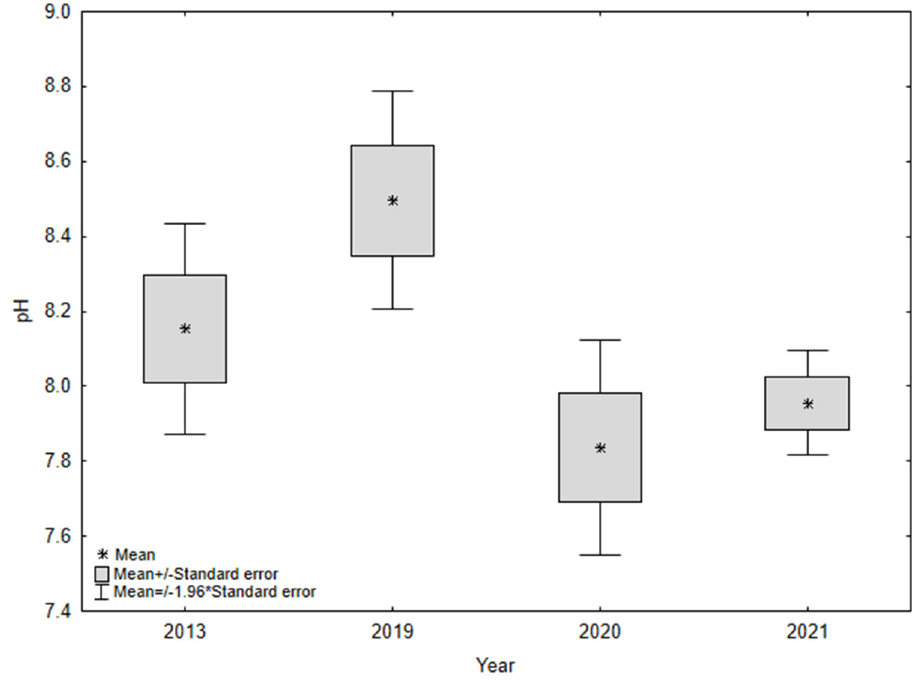
Figure 8. Average annual values of pH in the water of Lake Mielenko. The EC of the water of Lake Mielenko ranged from 382 to 794 µ S/cm. In 2013, the average value of the reaction was 427 ± 27.8 µ S/cm, while in 2021, a few years after the change of the catchment area management, the mean value of the EC was 754 ± 27.5 pH (Figure